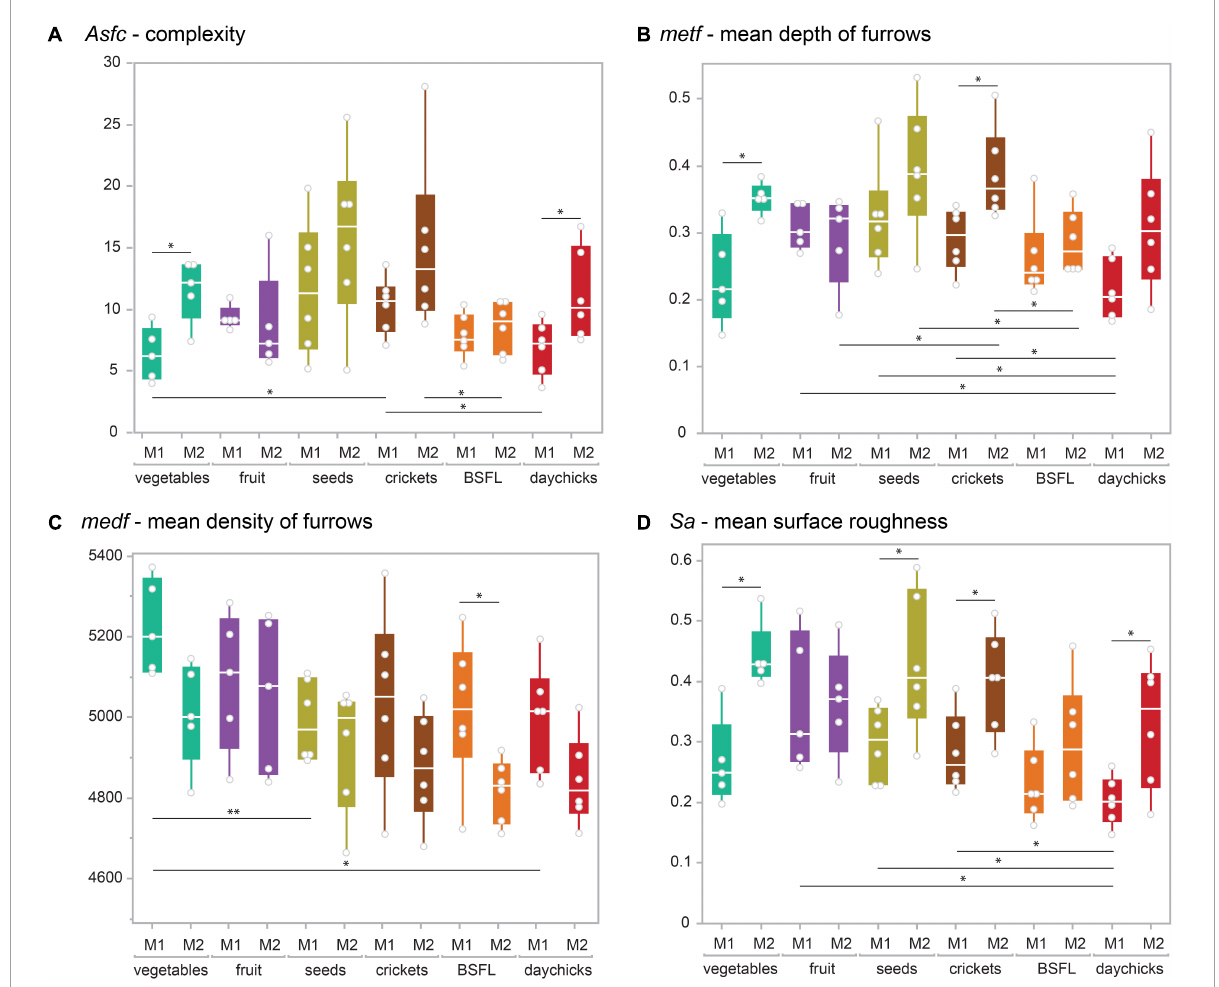
FIGURE3 Boxplots depicting representative (A) complexity ( Asfc ), (B) density ( medf ), (C) and height ( metf ), (D) ( Sa ) parameters for the first (M1) and second upper molars (M2) of all dietary groups. Significant differences between tooth positions within one dietary group are displayed above, while differences between dietary groups for the same tooth position are displayed below the boxplots. Significance levels: ∗ 0.05, ∗∗ 0.01, from the Wilcoxon test for multiple comparisons without correction. BSFL, black soldier fly